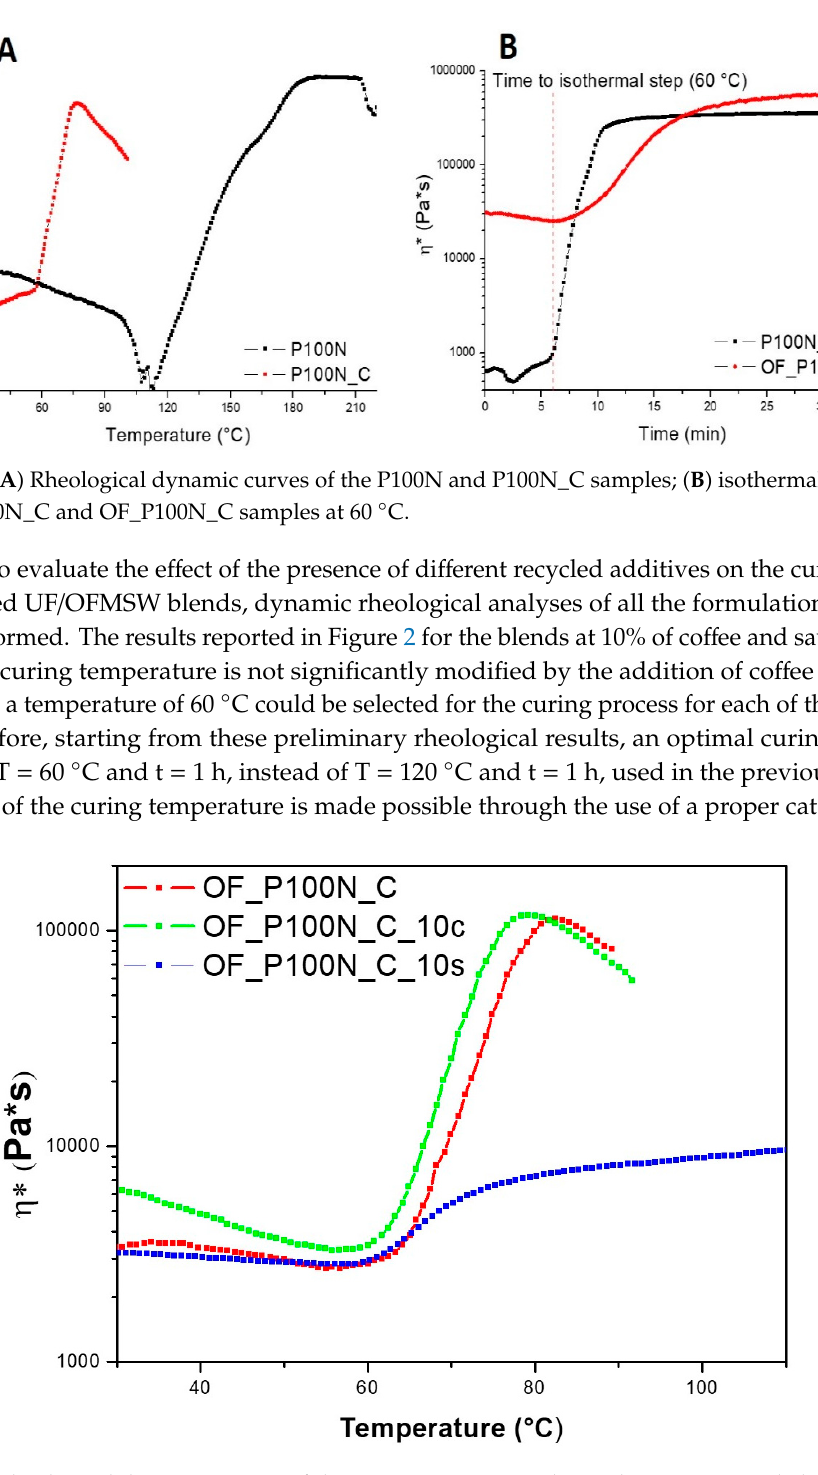
Figure 3. Pictures of the urea formaldehyde (UF)/ organic fraction of municipal solid waste (OFMSW) blends ( A ) before and ( B ) after the curing process.